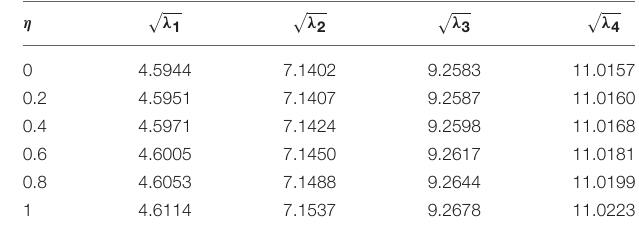
TABLE 17 | Frequency parameters parameters.